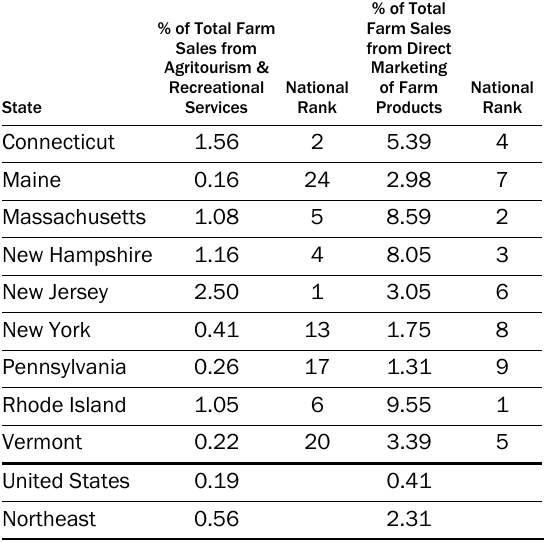
Table 2. Relative Reliance on Agritourism and Direct Marketing Income in the Northeast: Ranks Among Coterminous States